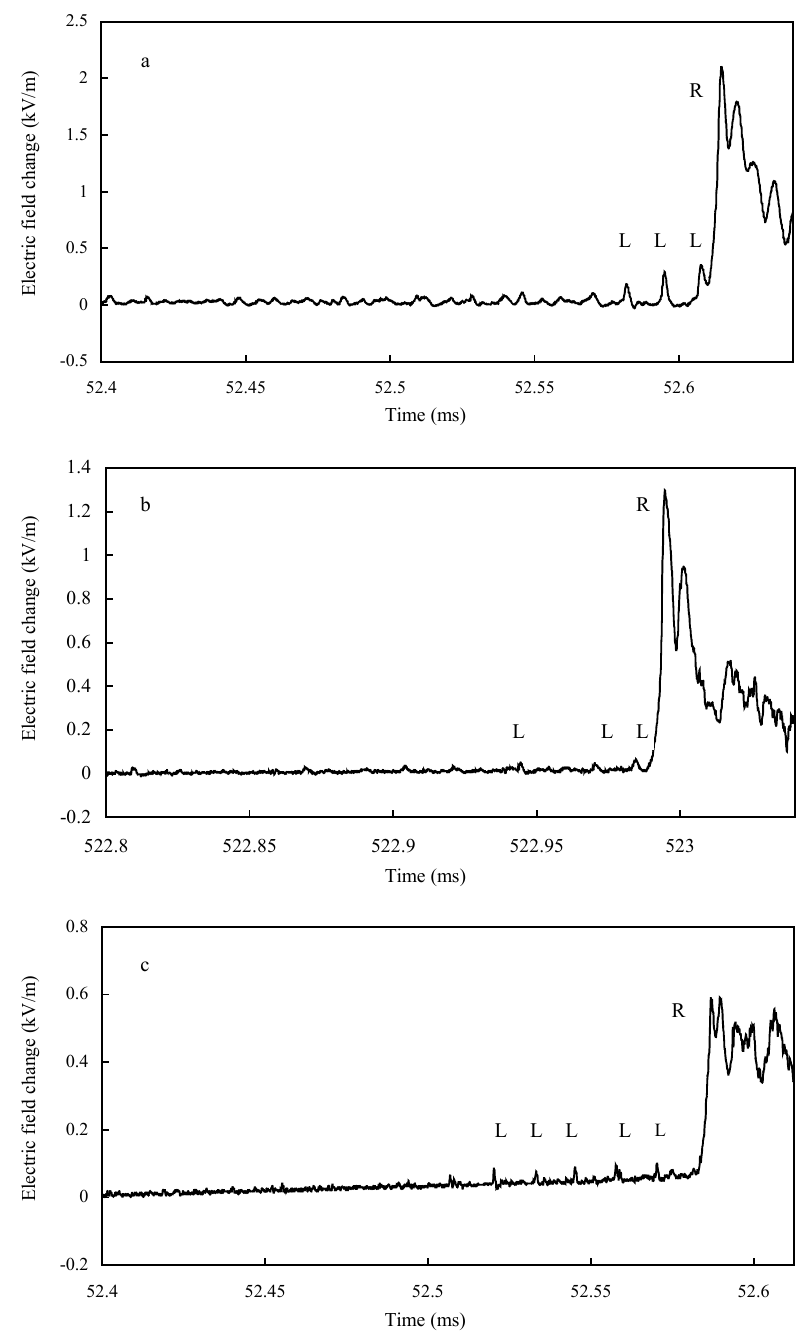
Fig. 3. Three categories of electric field changes between last stepped leader and the first return strokes.